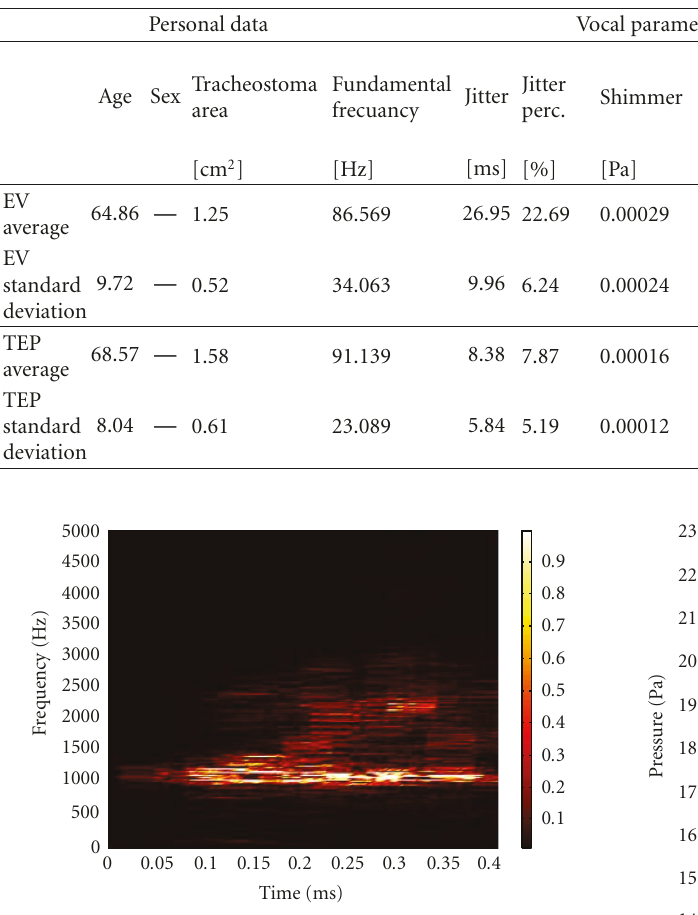
Table 2: Average and standard deviation for patient data, vocal, and pressure parameters.